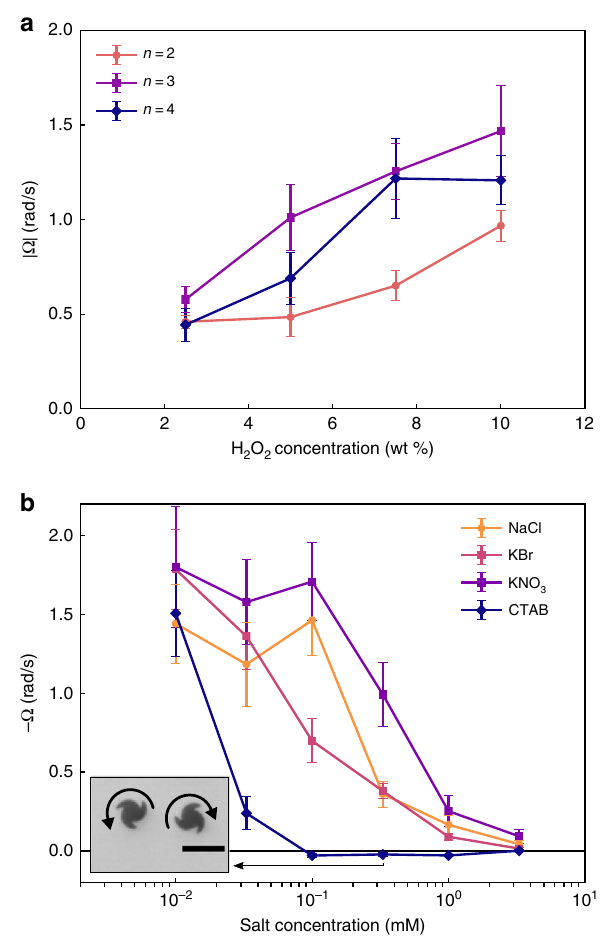
Fig. 3 Experiments supporting a self-electrophoretic propulsion mechanism. a Angular velocity as a function of hydrogen peroxide concentration for particles with shape asymmetry c = 2 and different numbers of fi ns n . Error bars represent 95% con fi dence intervals for the mean velocity. b Angular velocity as a function of salt concentration for particles with n = 3 fi ns and shape asymmetry c = 2 rotating in 10 wt% H 2 O 2 . The inset shows the rotation reversal with addition of 0.33 mM of the cationic surfactant CTAB (see Supplementary Movie 3); scale bar is 20 μ